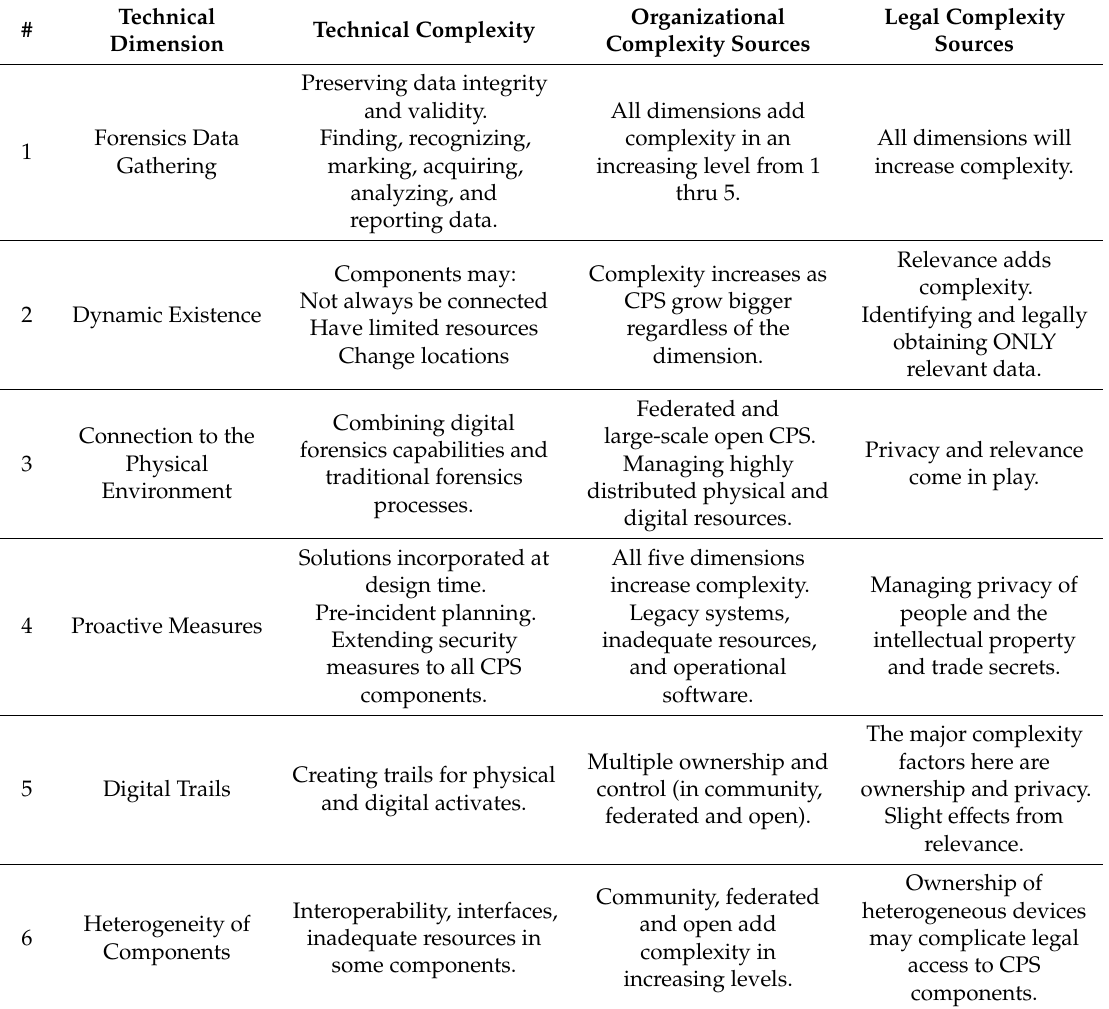
Technical dimensions and how legal and organizational dimensions increase CPS forensics